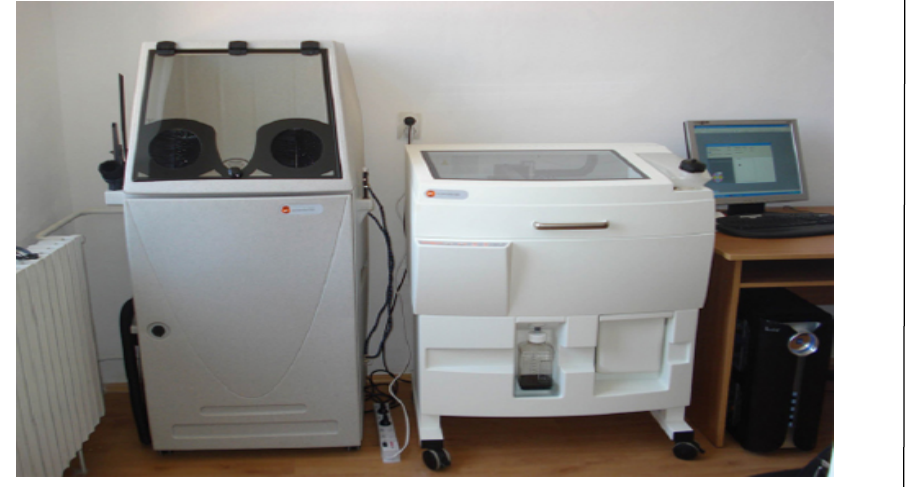
Figure 5 – Rapid Prototyping 3D Zcorp 310 system for managing i